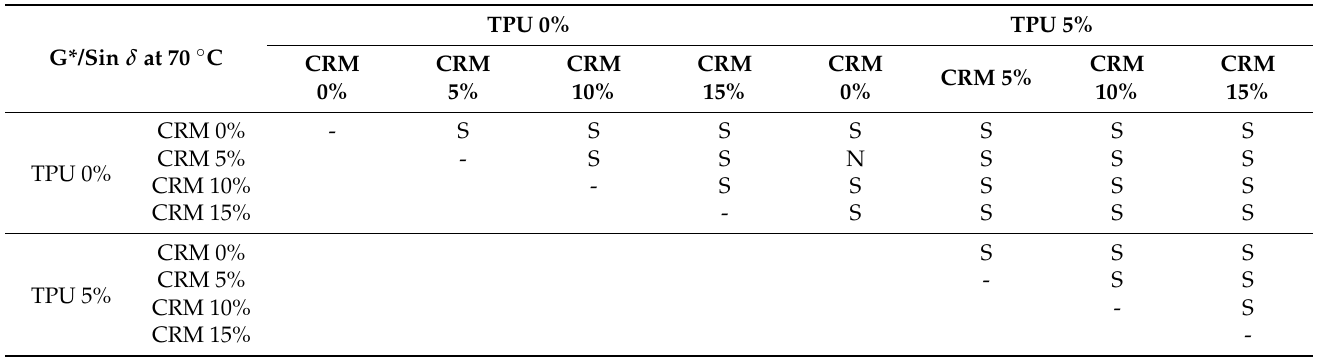
Figure 6. G*/sin δ of the asphalt binders containing CRM and TPU for original condition. Table 5. Statistical analysis results of the original G*/sin δ as a function of CRM contents and the addition of TPU ( α =